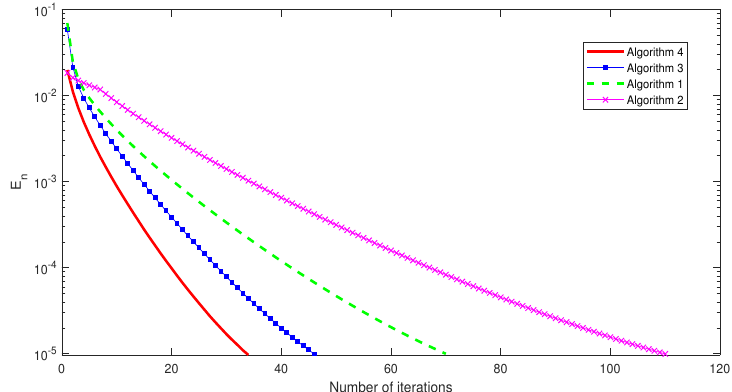
Figure 5. MSE versus number of iterations when N = 4096, M = 2048 and κ = 10 − 5 .